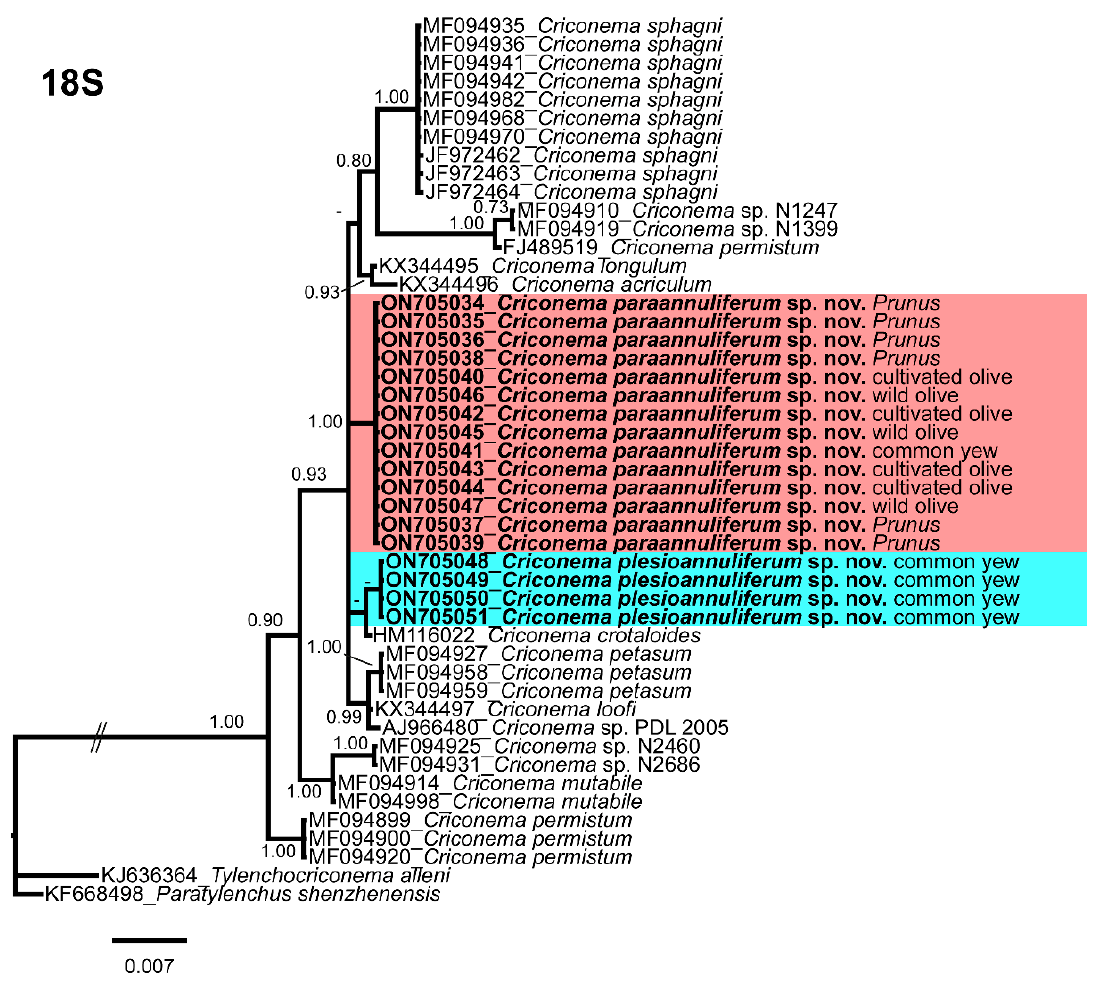
Figure 15. Phylogenetic relationships within the genus Criconema . Bayesian 50% majority rule consensus tree as inferred from 18S rRNA sequence alignment under the transition model with invariable sites and a gamma-shaped distribution (TIM2 + I + G). Posterior probabilities of more than 0.70 are given for appropriate clades. Newly obtained sequences in this study are in bold. The scale bar indicates expected changes per site, and the coloured boxes indicate the clade association of the Criconema annuliferum -complex.